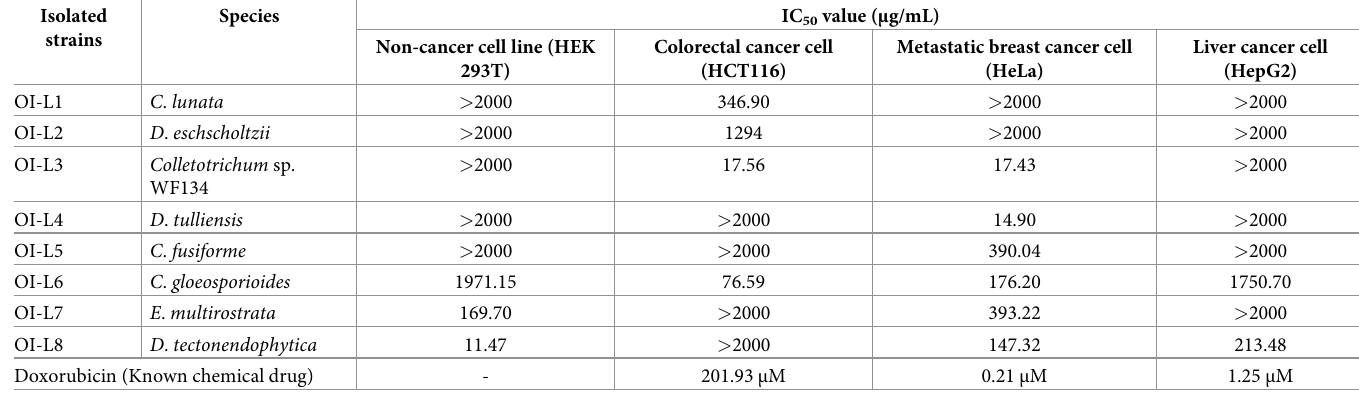
Table 3. Cytotoxic activity of EA extracts of eight fungal endophytes associated with the leaf of O . indicum against non-cancer and cancer cell lines. Isolated strains